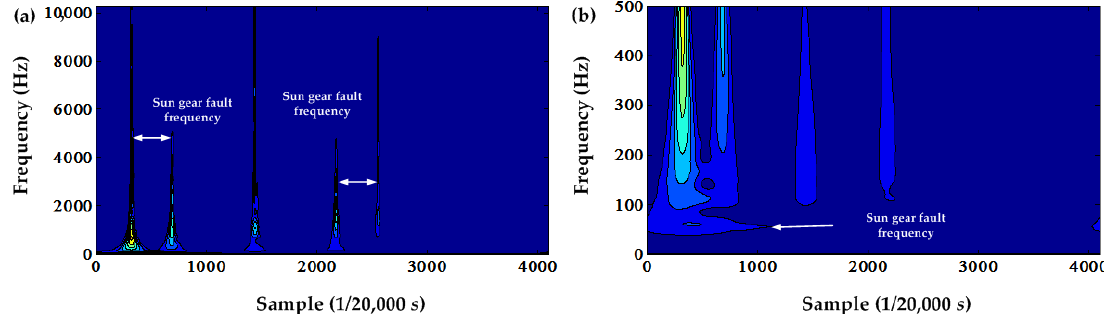
Figure 23. ( a ) Time-frequency contour of the squared envelope signal using the S transform; ( b ) local amplification of ( a ).